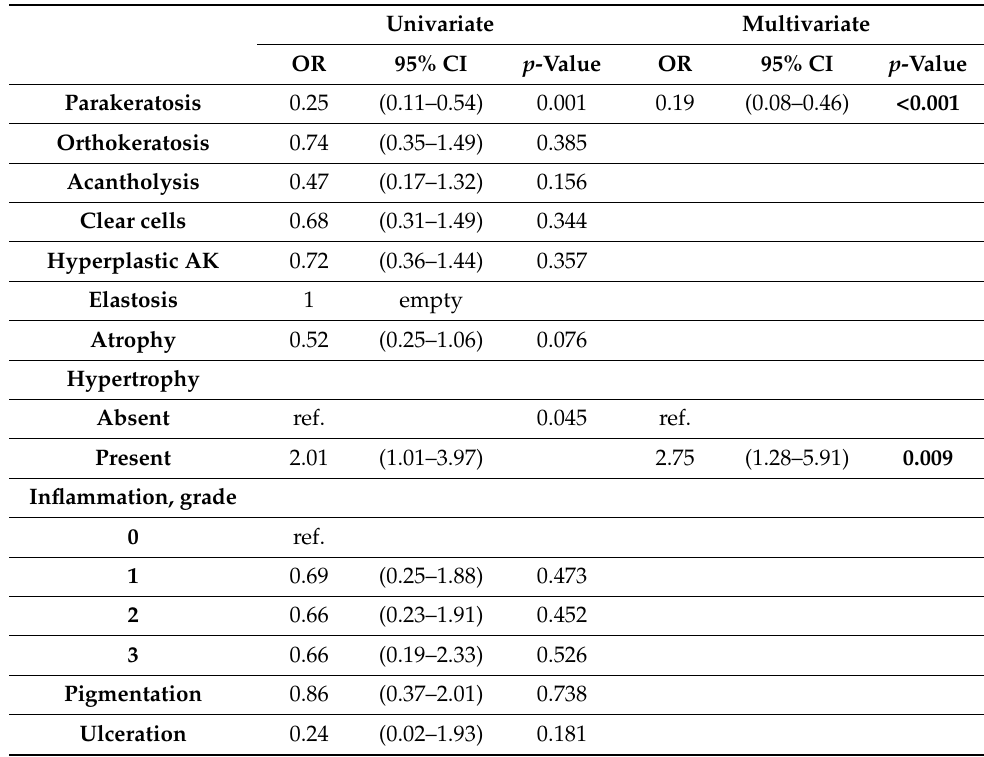
Table 3. Univariate and multivariate logistic regression model of the risk of association between histopathological features of AK and